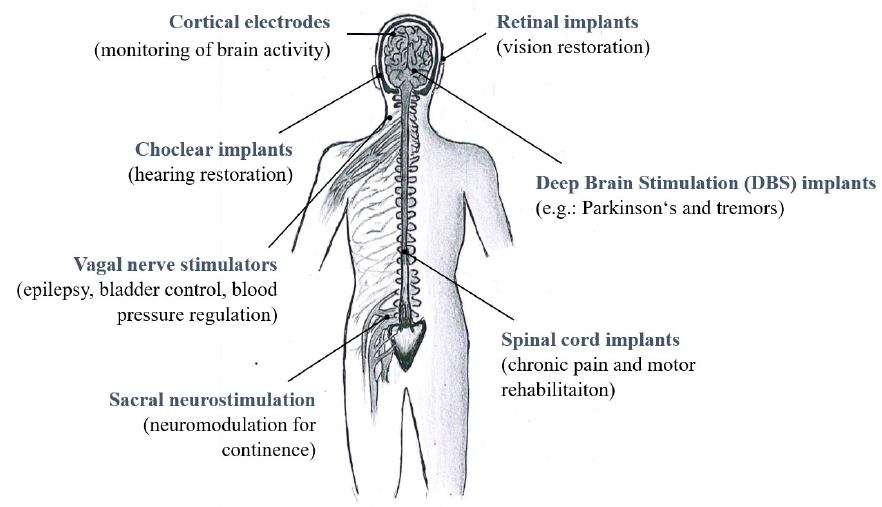
Figure 1. Sketch with examples of different types of neural implants in different sections of the human nervous system with examples of main clinical applications.